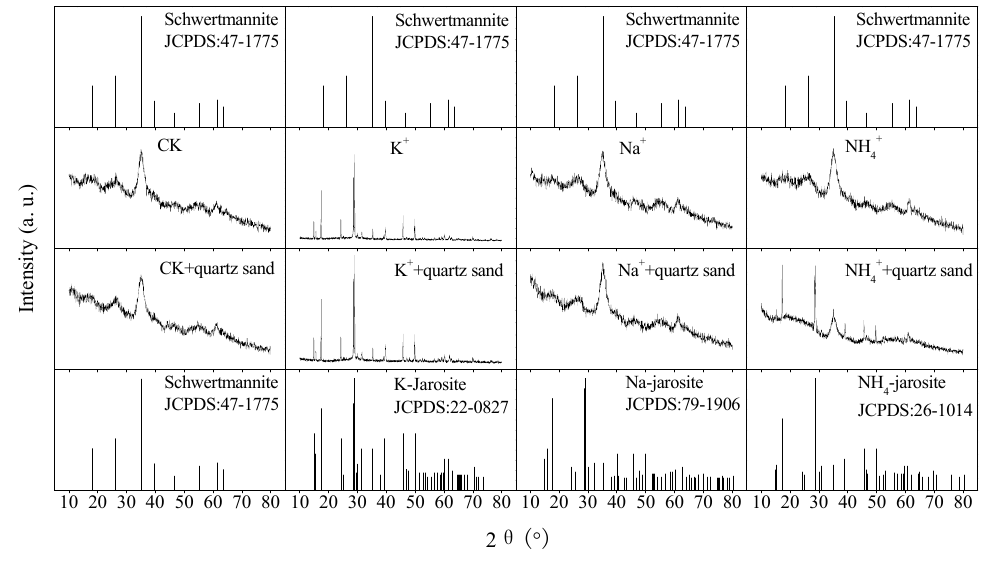
Figure 5. X-ray diffraction patterns of the secondary iron minerals for different biomineralization treatments.